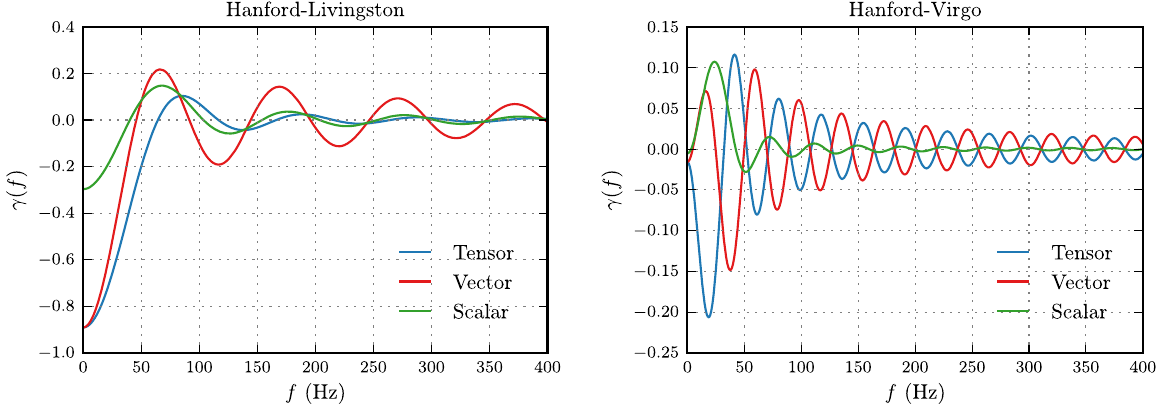
FIG. 2. Overlap reduction functions quantifying the sensitivities of the Hanford-Livingston (left) and Hanford-Virgo (right) baselines to isotropic backgrounds of tensor-, vector-, and scalar-polarized gravitational waves. The distance between Hanford and Virgo is much larger than that between Hanford and Livingston; the Hanford-Virgo overlap reduction functions are therefore smaller in amplitude and more rapidly